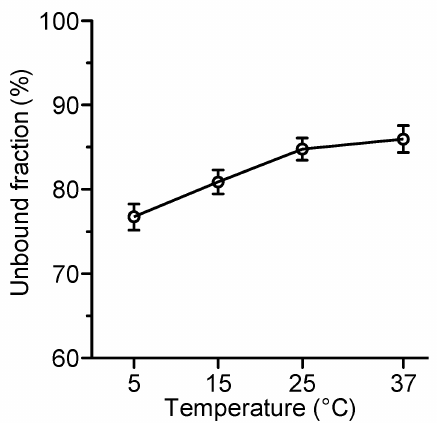
Figure 2: Influence of temperature on the protein binding of moxifloxacin in human plasma, buffered with potassium phosphate to 7.4, as determined by ultrafiltration. Mean±SD of 4 independent experiments with moxifloxacin 3 or 0.3 mg/L (n=8)